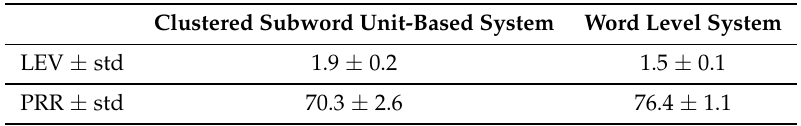
Table 3. Levenshtein distance (LEV) and phone recognition rate (PRR) results of the lexicon inferred from clustered subword unit-based KL-HMM system and word level KL-HMM system.